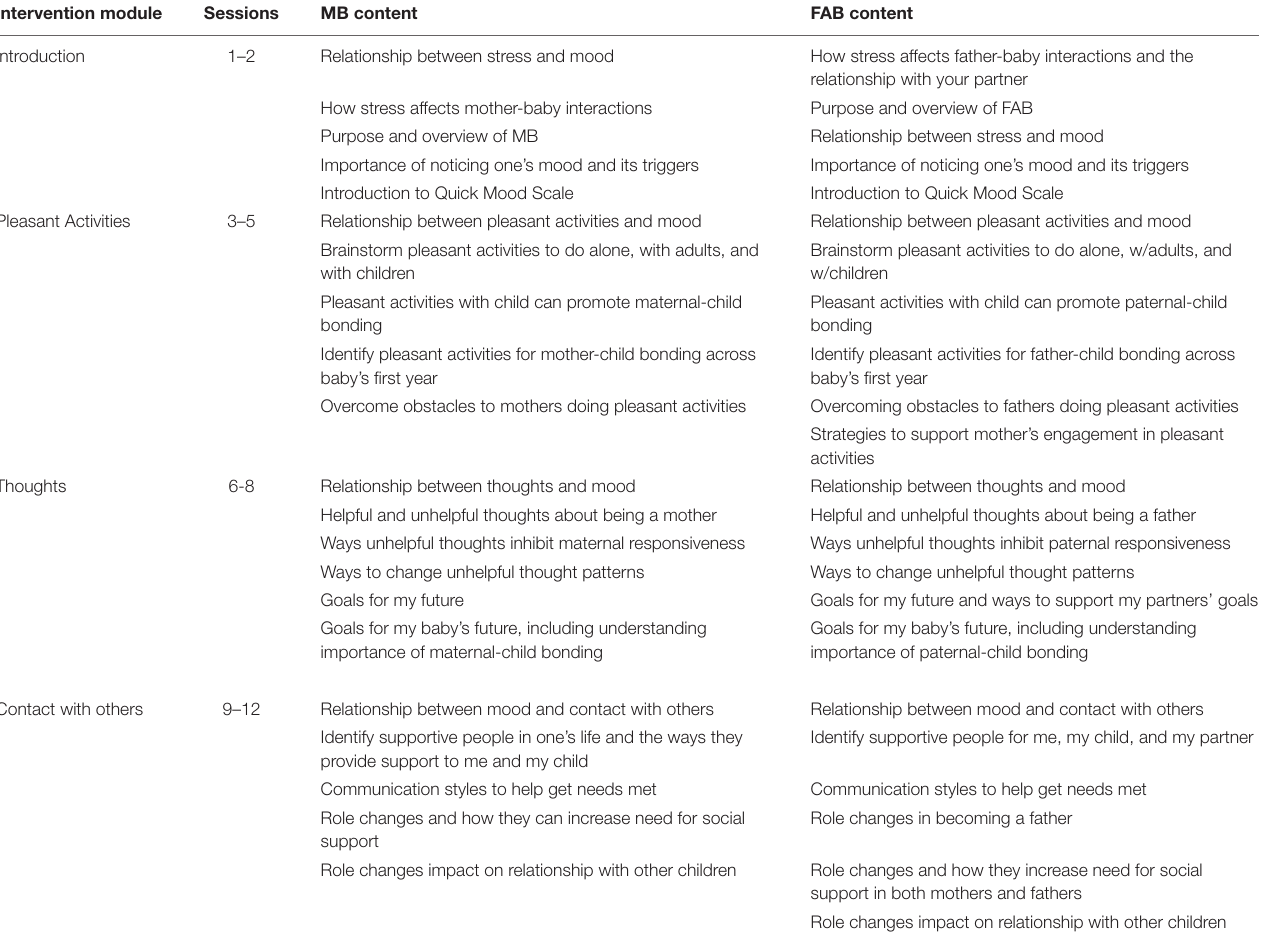
TABLE 3 | Overview of Mothers and Babies (MB) and Fathers and Babies (FAB) content, by intervention module. Intervention